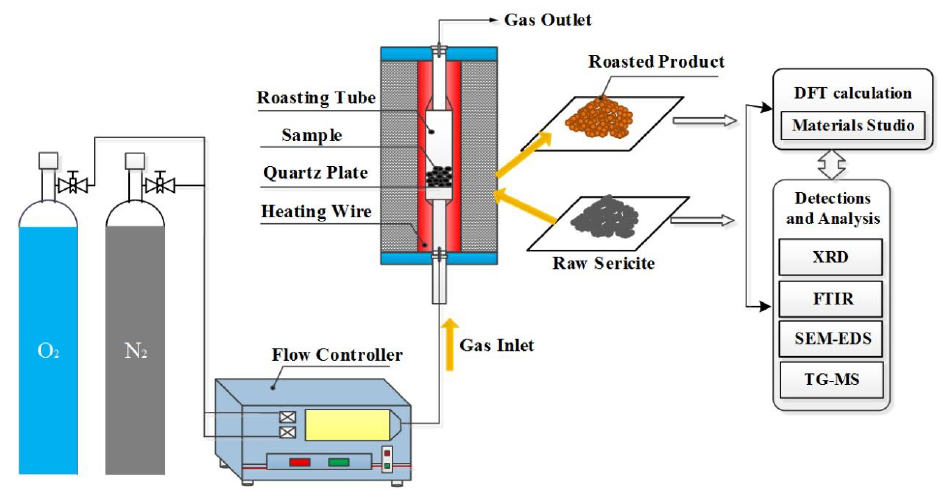
Figure 3. Schematic of sericite fluidized roasting system.